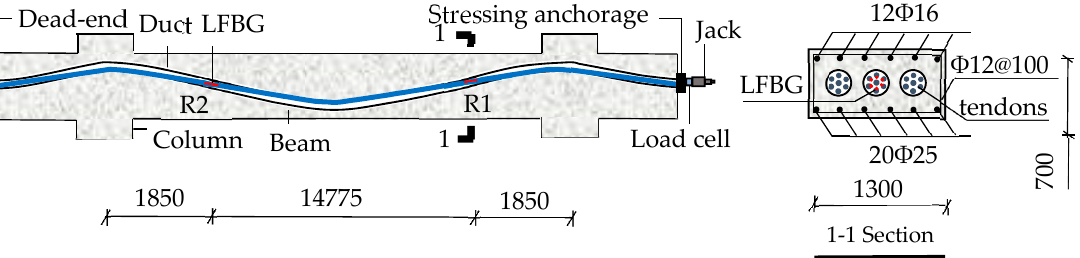
Figure 10. The schematic of the monitored beam in in-site measurement.